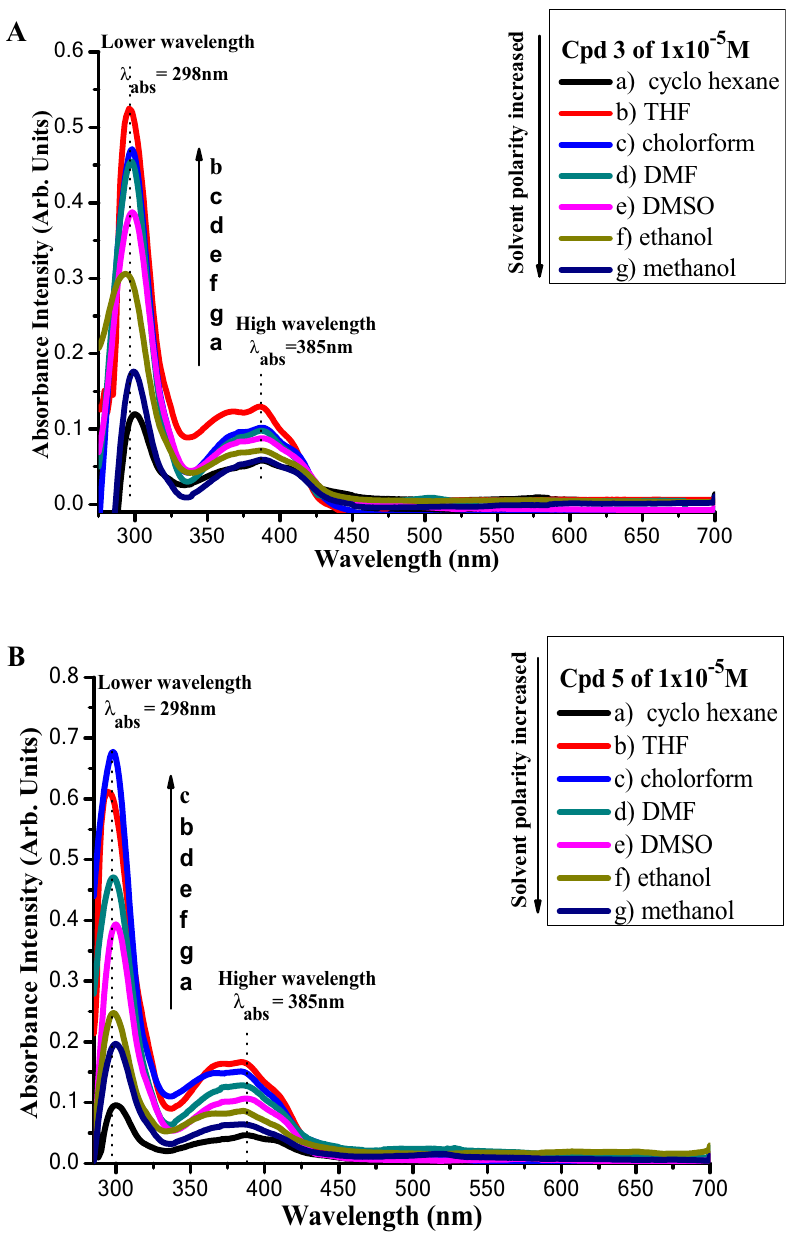
Figure 9. ( A , B ).Absorption of compounds 3 and 5 of concentration 1 × 10 −5 M in different